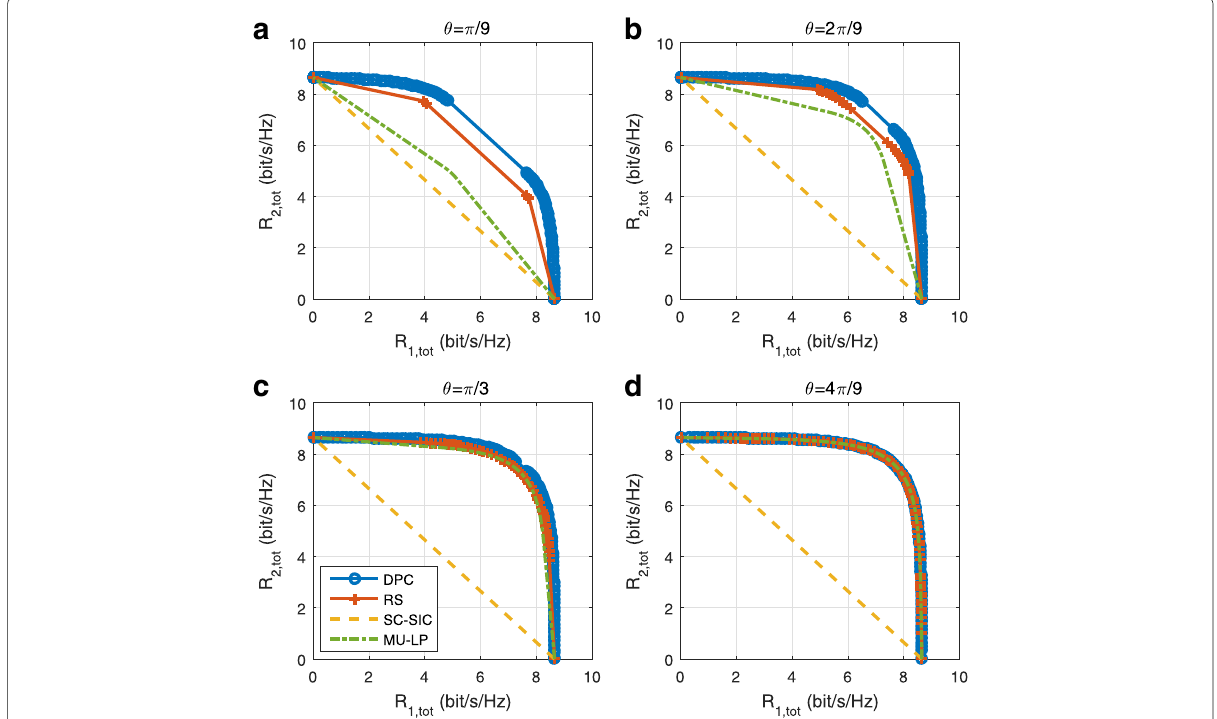
Fig. 7 Achievable rate region comparison of different strategies in underloaded two-user deployment with perfect CSIT, γ = 1 and N t = 4, SNR = 20 dB. a θ = π/ 9. b θ = 2 π/ 9. c θ = π/ 3. d θ = 4 π/